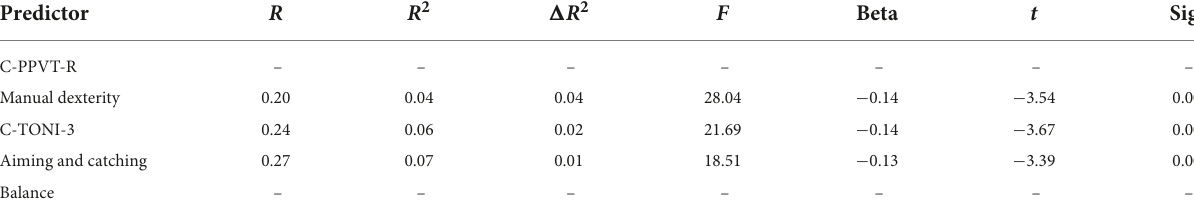
TABLE 7 Linear regression analysis for the predictive effect of subtest of MABC2 on color RAN. Predictor